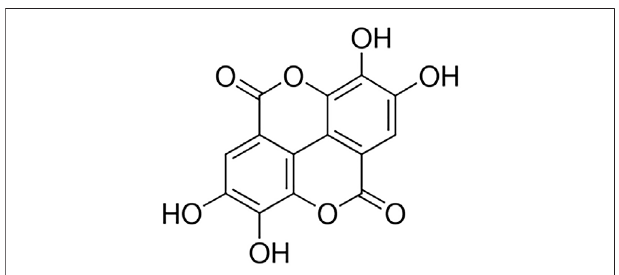
FIGURE 1 | Chemical structure of ellagic